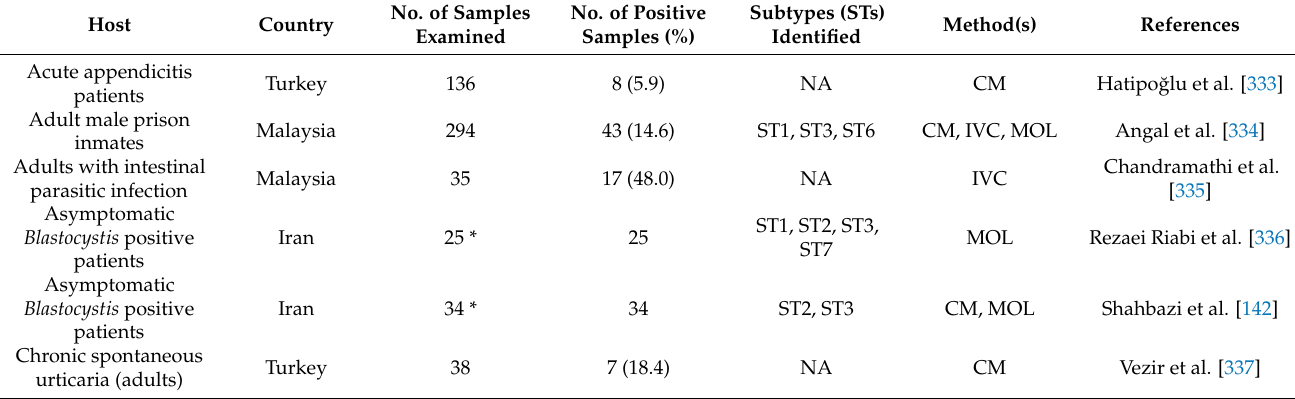
Table 8. Prevalence and subtype distribution of Blastocystis spp. in various human categories in Asia